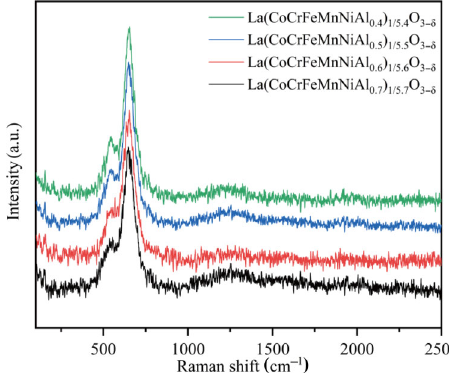
Fig. 5 Raman spectra recorded for the HEPO materials. Table 2 Raman peaks of La(CoCrFeMnNiAl x ) 1/(5+ x ) O 3 − δ Maximum of Area of the x the band band ×10 3